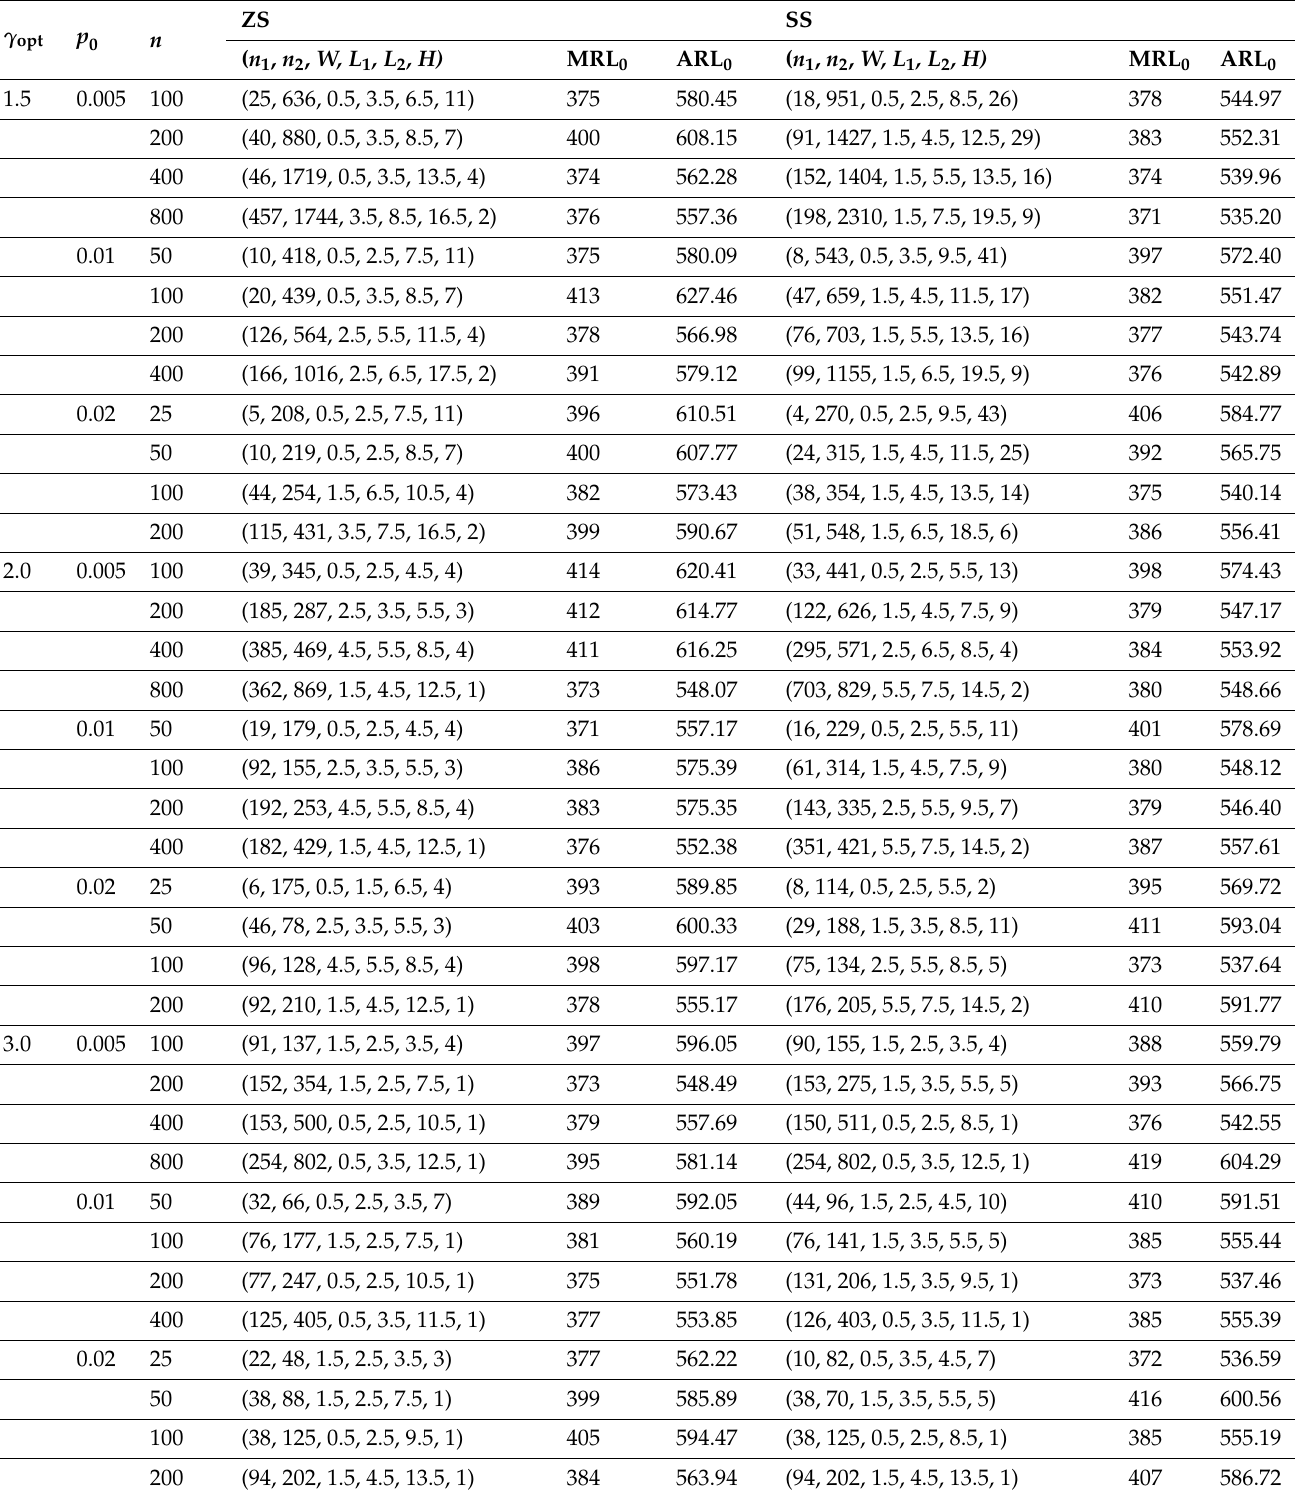
Table 1. Optimal charting parameters for the MRL-based SDS np chart, in ZS and SS modes, together with their corresponding values of MRL 0 and ARL 0 , when RL 0min =